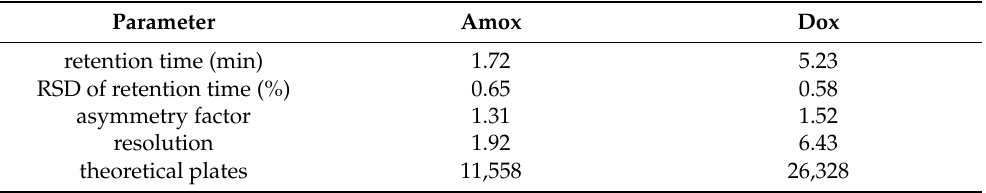
Table 1. Parameters of the HPLC-DAD Method for the Simultaneous Determination of Amox and Dox. Parameter Amox Dox retention time